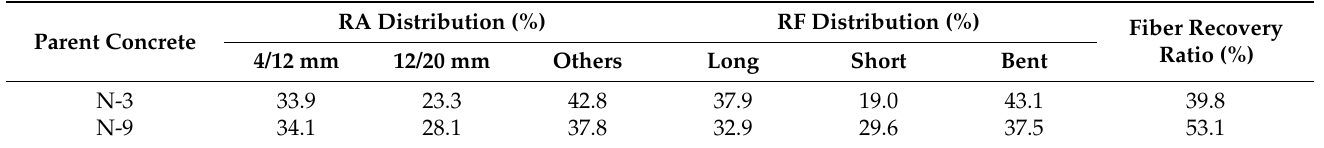
Table 3. Parent concrete output